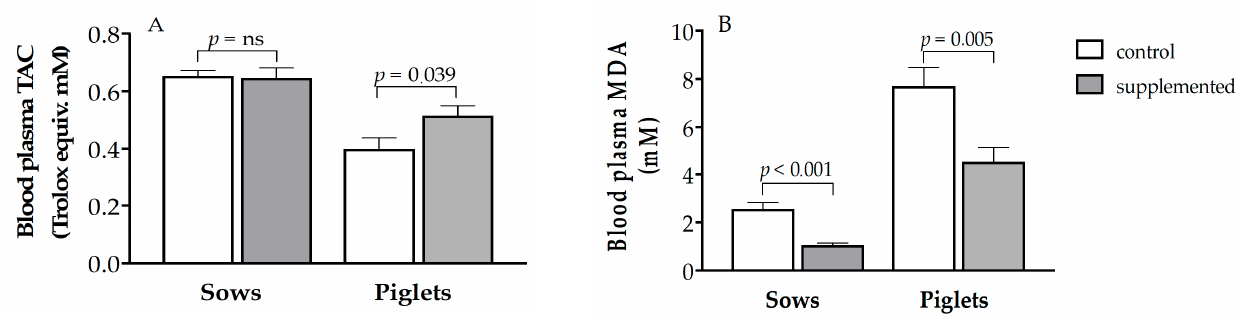
Figure 2. Mean values (± S.E.M.) of plasma total antioxidant capacity (TAC; panel A ) and malondialdehyde (MDA; panel B ) at day of farrowing in sows and newborn piglets treated or not with herbal antioxidants. ns = not significant.